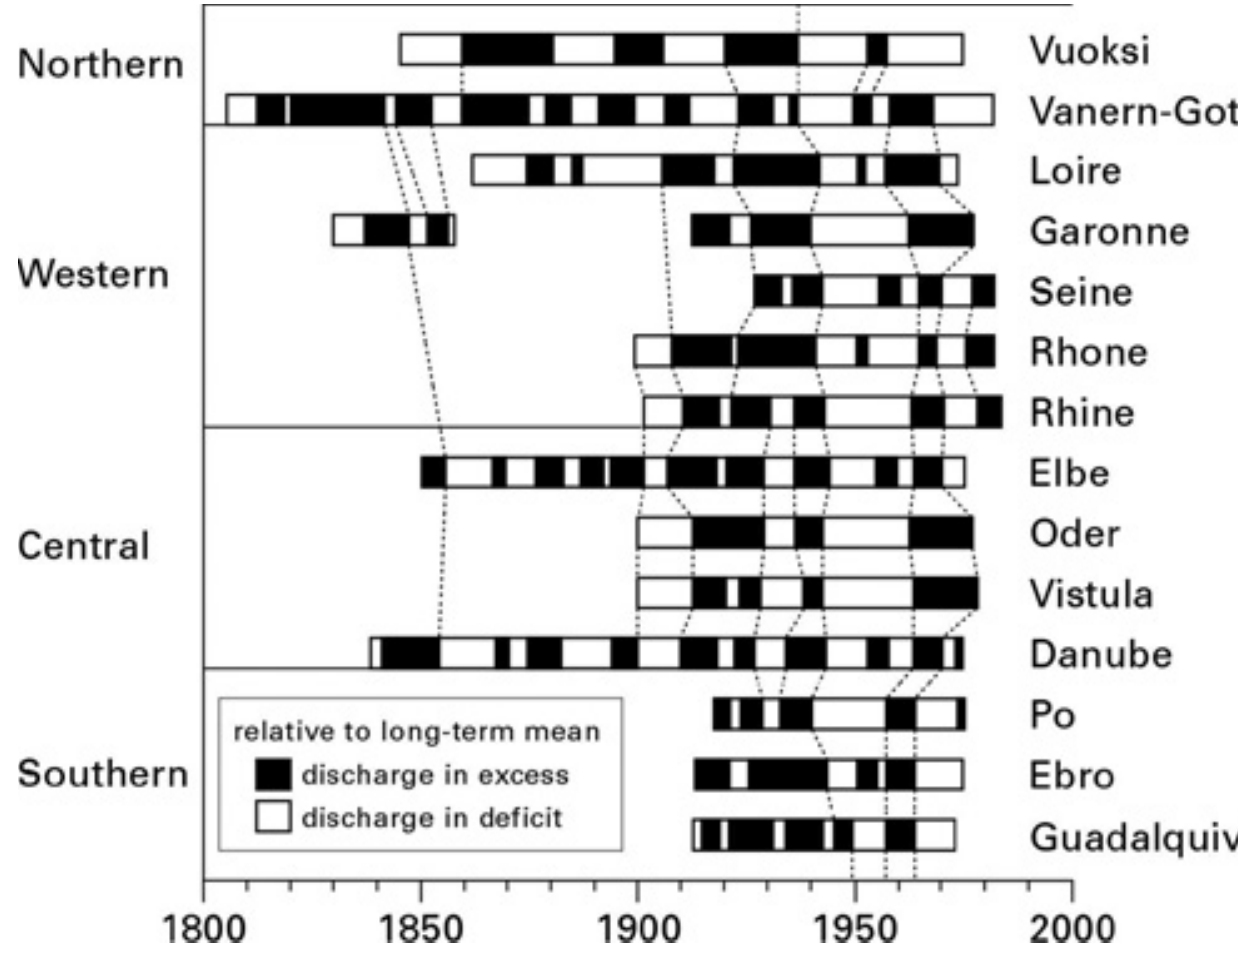
Fig. 1. Fluctuations in mean annual discharge in relation to the long-term mean for a range of large European river systems. Values were determined using 5-yr moving average curves. Humid intervals can be